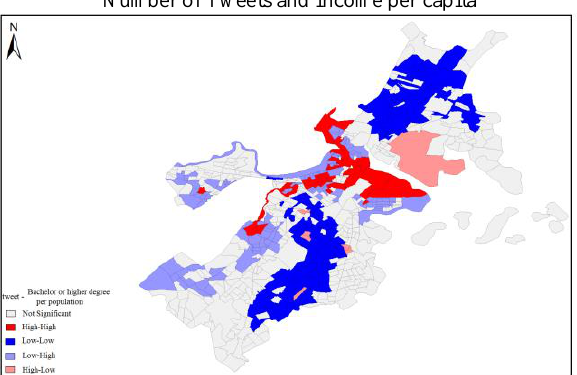
Figure 3. Clusters Showing the Spatial Correlation of the Number of Tweets and Income per capita